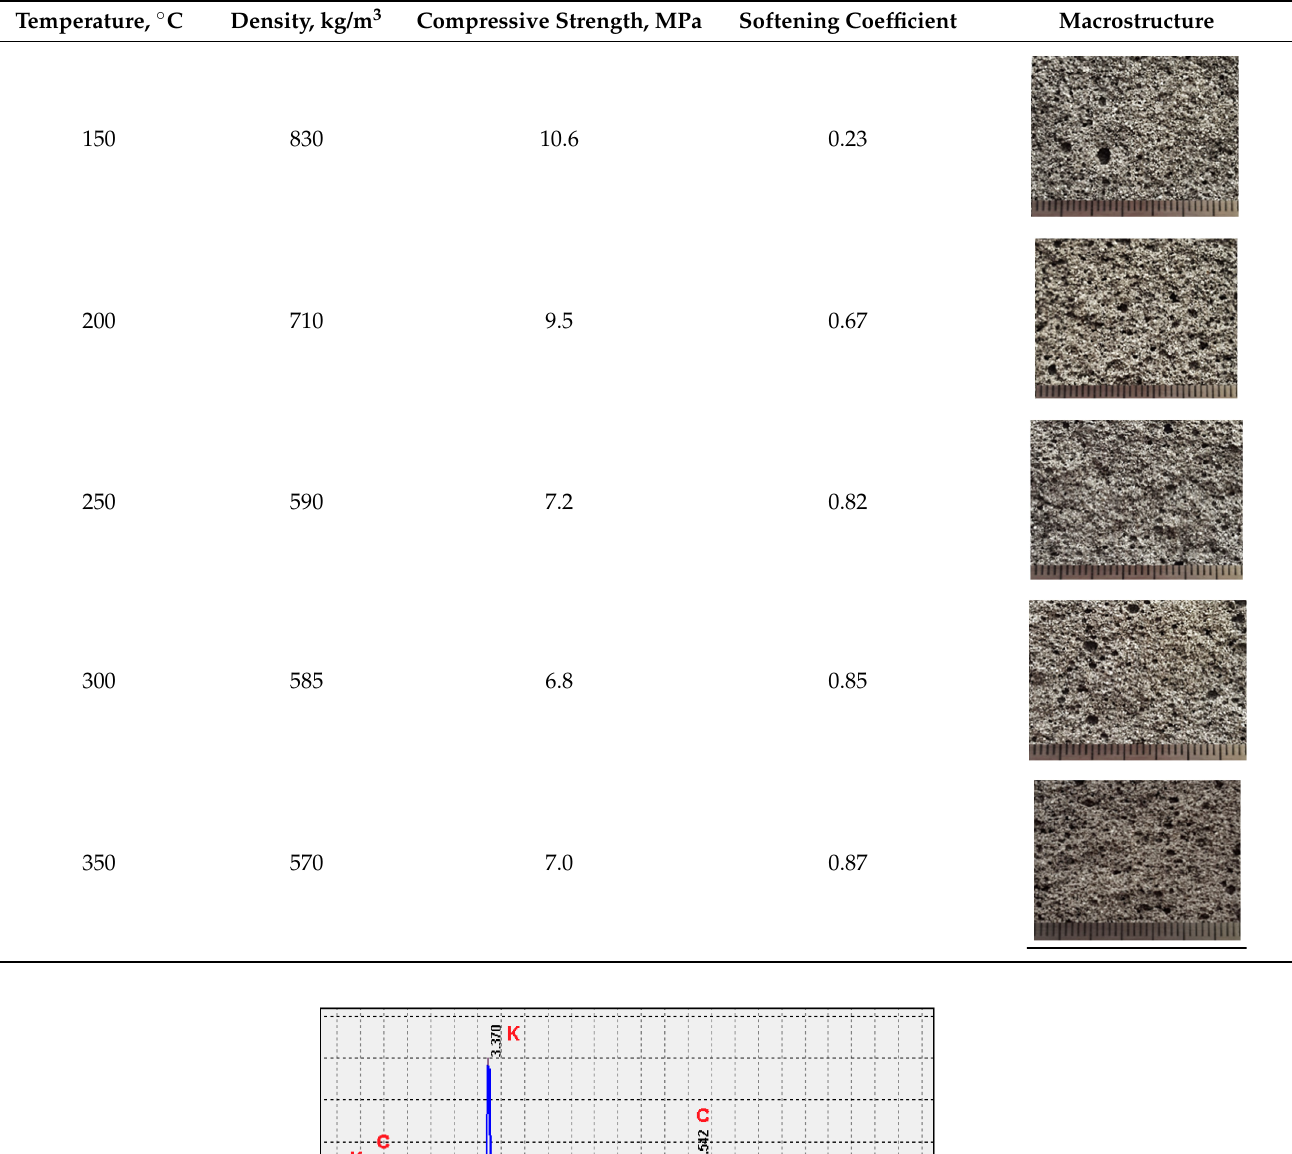
Table 8. Influence of firing temperature on the properties of liquid glass binder (mixture 39).